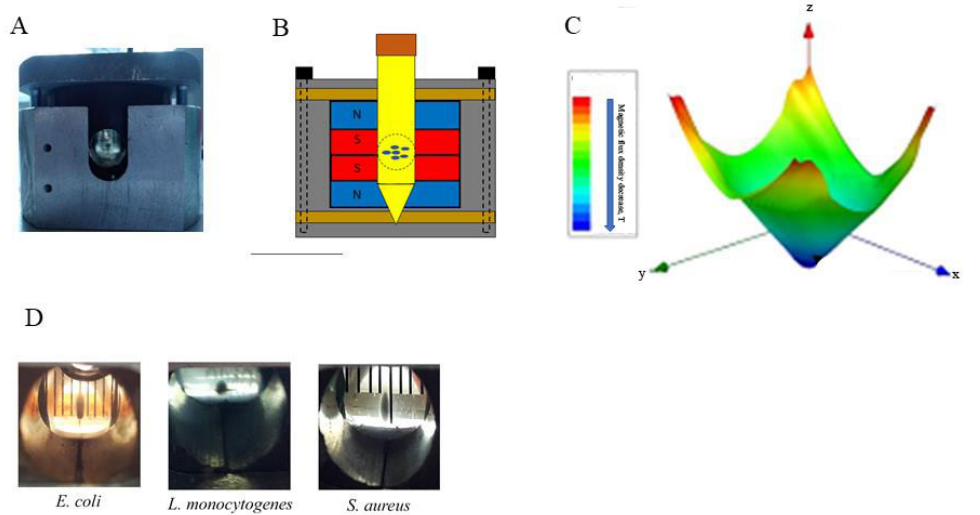
Figure 2. Scheme of the MagLev system used to separate suspended diamagnetic particles including bacteria. Arrows represent forces affecting the particle: green is a magnetic force; yellow is a gravitational force; violet is an Archimedes force. The gradient of the gray represents the magnetic field strength that decreases as the distance from the magnets. The particle levitates at the point where the vector sum of the magnetic and Archimedes forces counterbalances gravity. Particles are separated depending on their density.